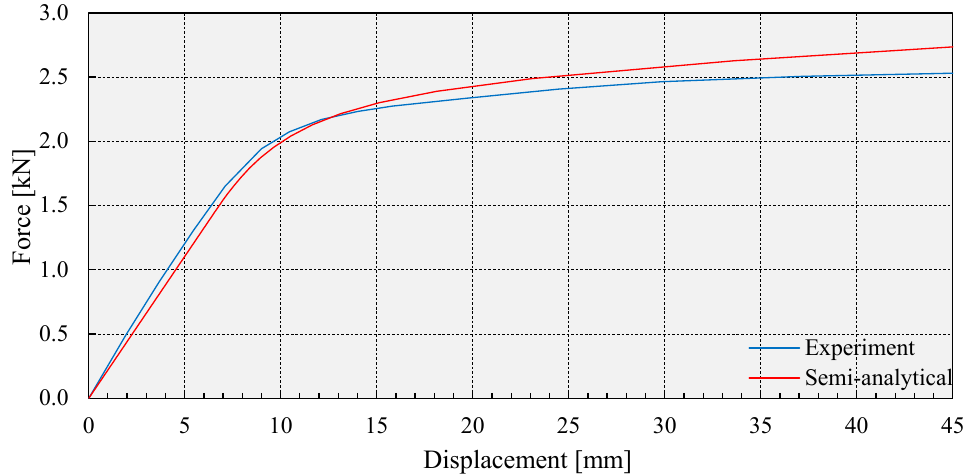
Figure 8. A force–displacement diagram for VC1.